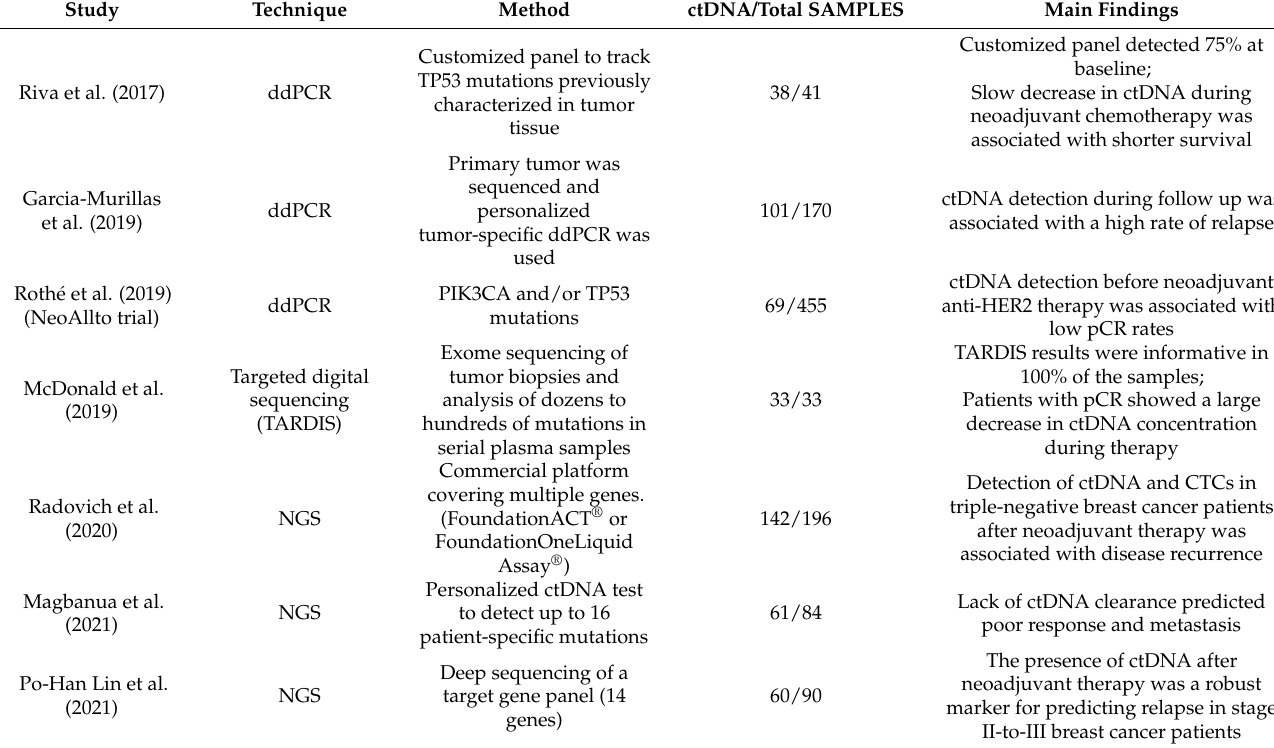
Early breast cancer studies monitoring ctDNA in the neoadjuvant chemotherapy setting